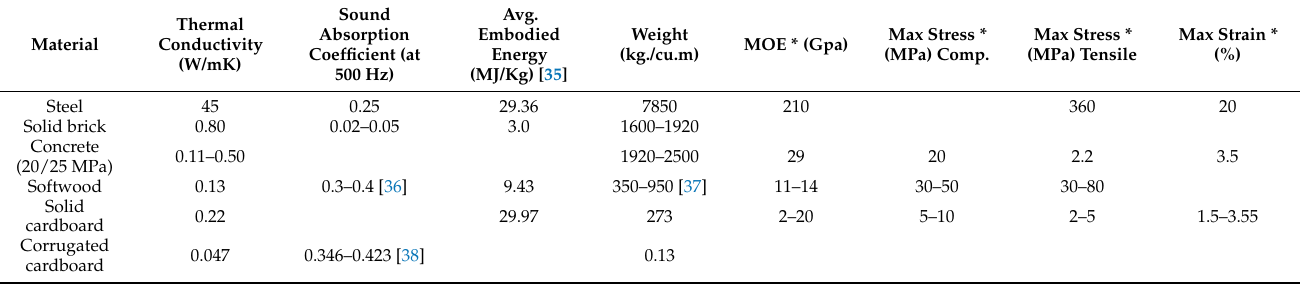
Table 3. Comparison of mechanical, thermal, and physical properties of general cardboard with other building materials